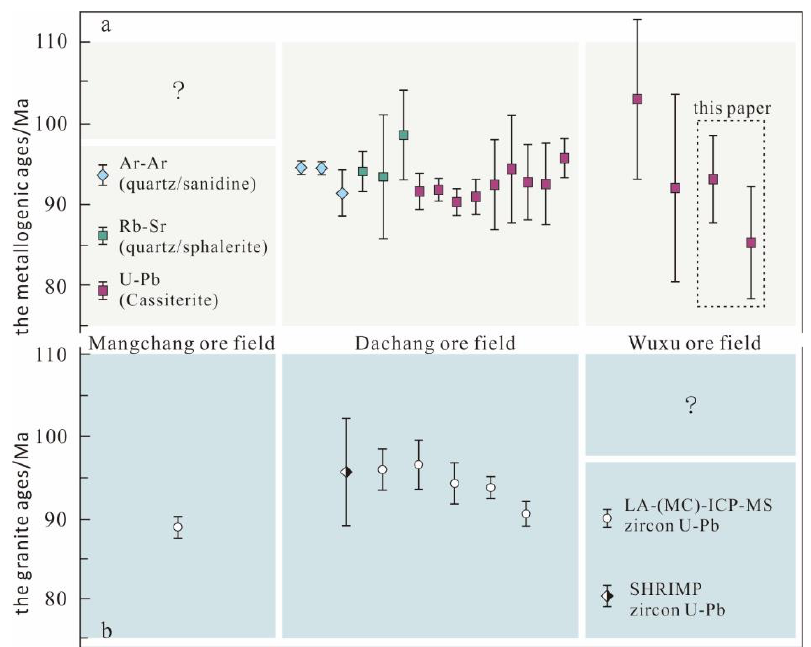
Figure 7. Metallogenic ages of the main tin–polymetallic deposits ( a ) and the ages of related granite ( b ) in the Nandan-Hechi metallogenic belt [20,27,28,47–53]. ?—there is no